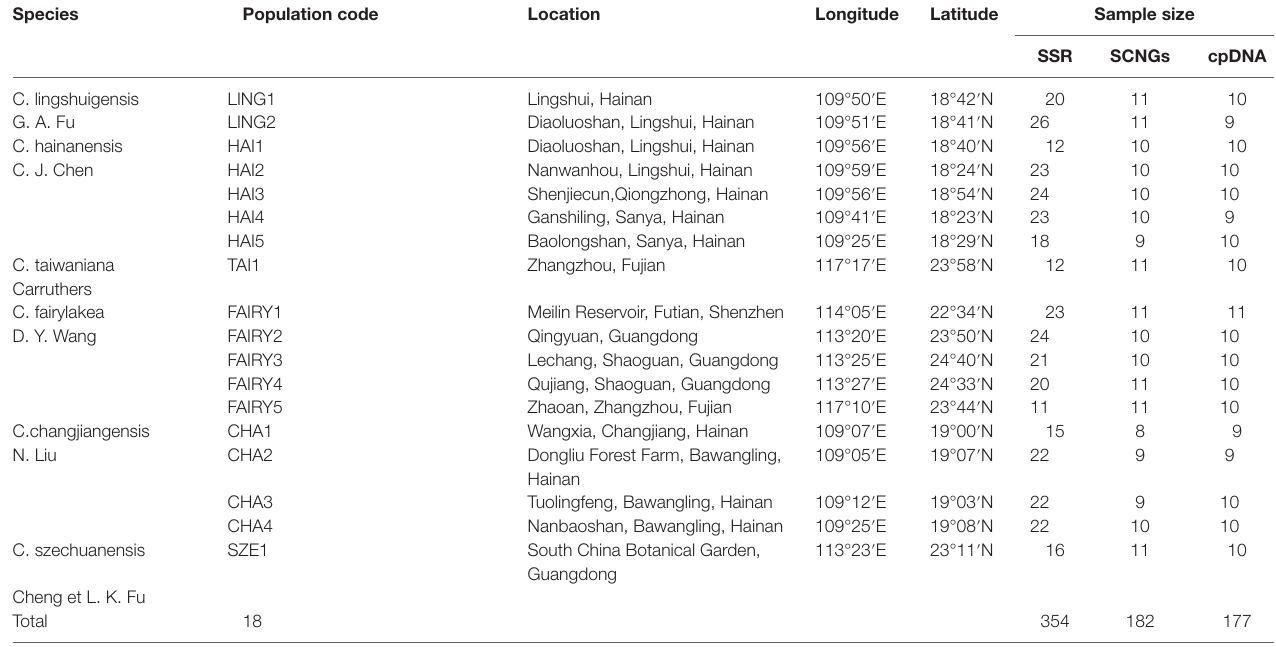
TABlE 1 | Locations and sample sizes of 18 populations of the Cycas taiwaniana complex surveyed for microsatellites and DNA sequences. Species Population